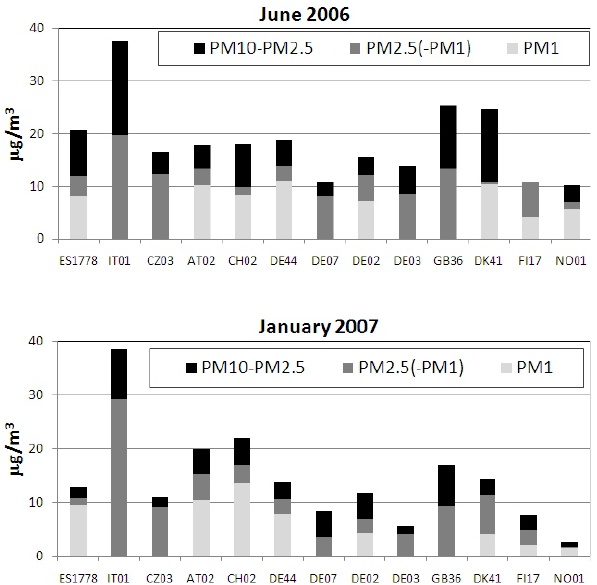
Fig. 3. Size distribution of the aerosol mass during the EMEP in- tensive measurement periods. Note that not all the sites have PM 1 measurements. PM 2 . 5 (PM 1 ) is the difference between PM 2 . 5 and PM 1 for those sites having both these measurement, otherwise it is representing the PM 25